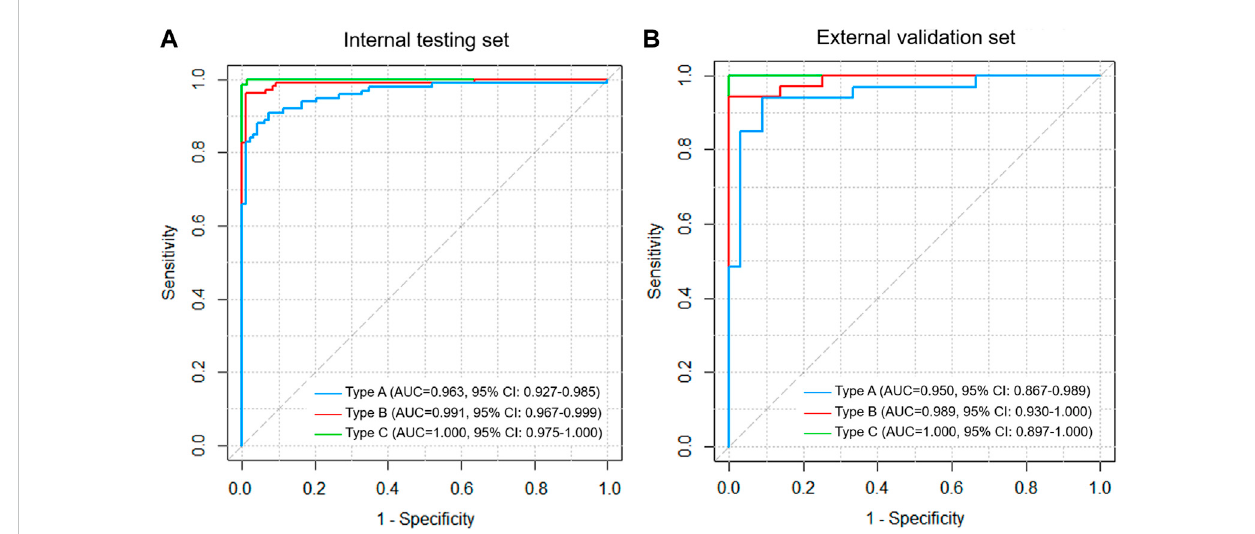
FIGURE 3 ROC curve analysis for types A, B, and C fractures based on the three-column classi fi cation of acetabular fractures in the (A) internal testing and (B) external validation